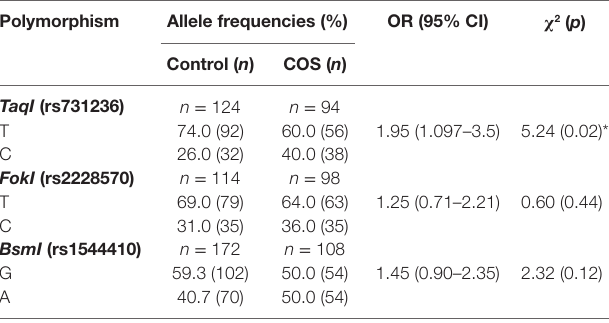
TaBle 4 | Allele frequencies of VDR polymorphisms.